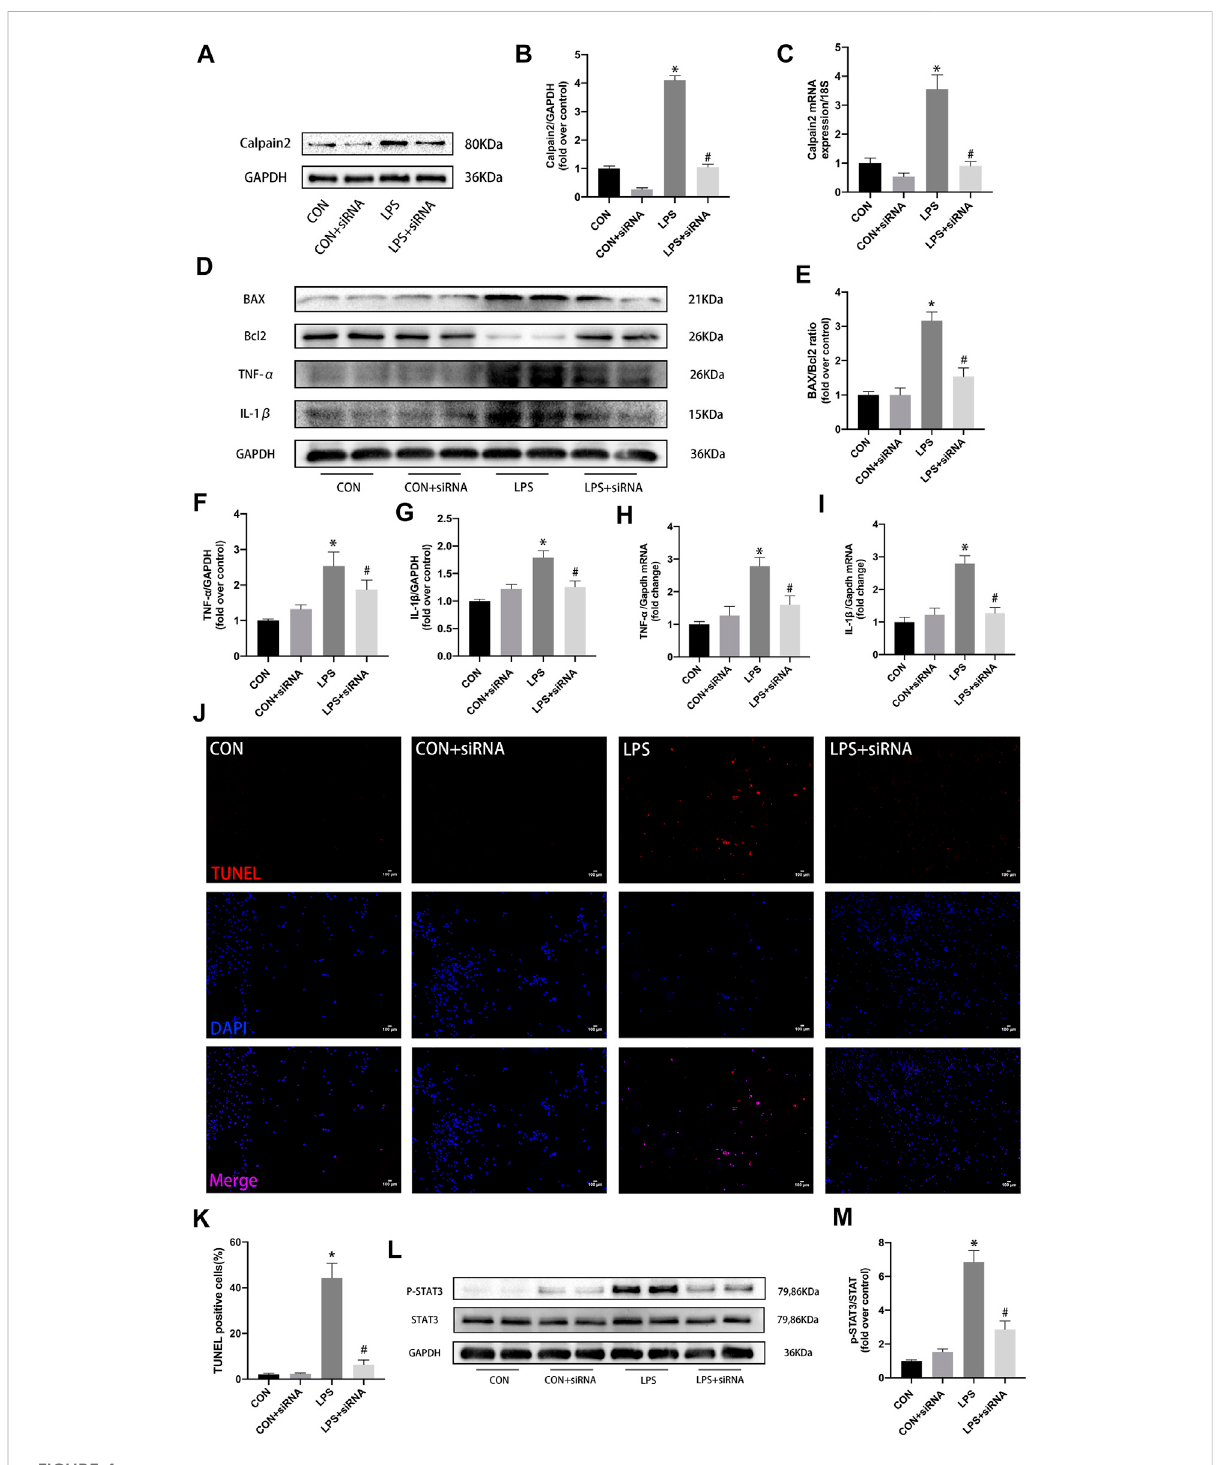
Role of calpain-2 inhibition in the expression of proin fl ammatory factors, apoptosis, and p-STAT3 in LPS-induced cadiomyocytes. (A) Representative blot images of calpian-2 using calpain-2 siRNA. (B – C) The quantitative analysis of protein and mRNA expression of calpain-2. (D) Representative images of western blots for BAX,Bcl2,TNF- α and IL-1 β . (E – G) The quantitative analysis of protein expression of BAX\Bcl2,TNF- α and IL-1 β . (H – I) mRNA expression of Tnf- α and Il-1 β in mouse heart. (J) TUNEL staining, apoptosis positive cells (red), nuclei (blue). (K) Quantitative analysis for TUNEL postive cells. (L) Representative images of western blots for P-STAT3, STAT3 and GAPDH. (M) Quantitative results of P-STAT3 to STAT3 total protein. N = 4 per group. * p < 0.05 vs. CON group, # p < 0.05 vs. LPS